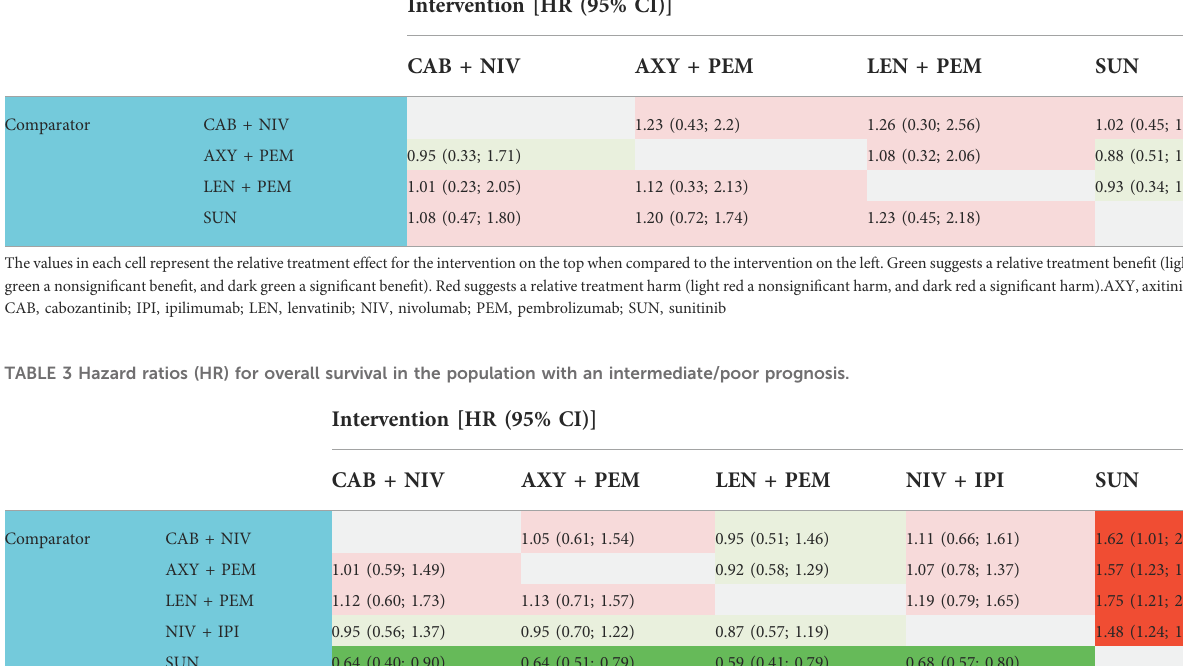
TABLE 2 Hazard ratios (HR) for overall survival in the population with a favorable prognosis.